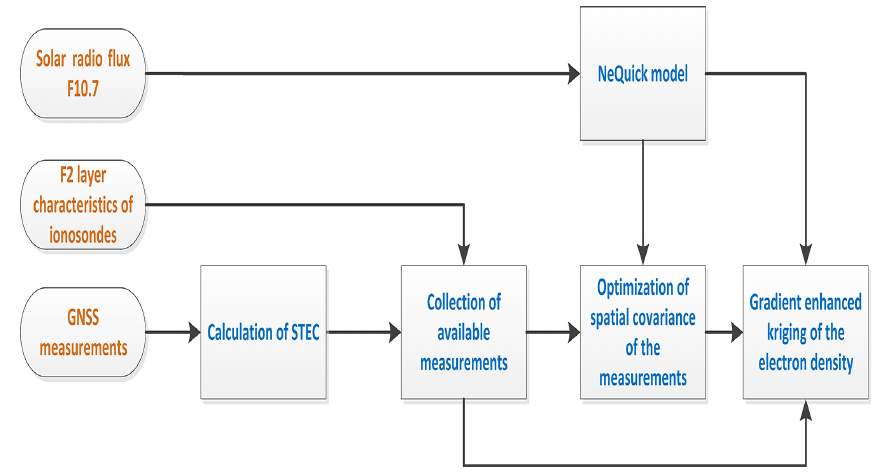
Figure 1. Work flow of gradient enhanced kriging with a spatial covariance model.